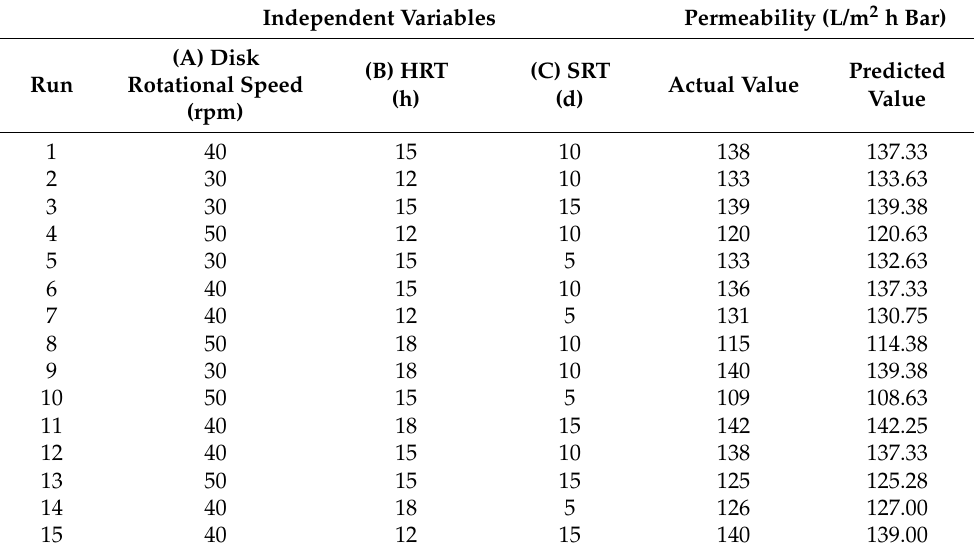
Table 5. Box–Behnken design matrix for independent variable and response of membrane permeabil- ity at three-factor levels. Independent Variables